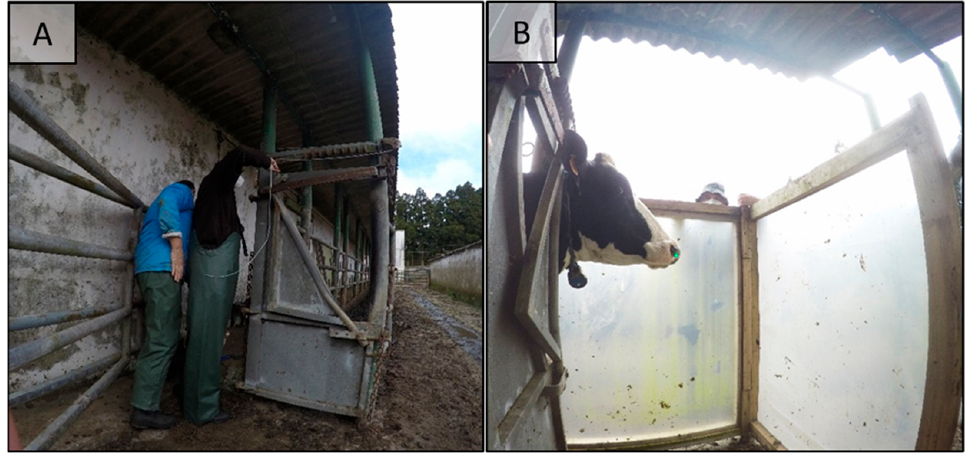
Figure 1. The actual image of the place where LMD was operated, captured with a wide-angle lens. ( A ) Handling race with a cattle head holder at the end for cattle contention; ( B ) positioning of wind protection panels during an LMD measurement (laser is visible as a green dot in the right nostril). A series of algorithms were created to collate individual files containing the measured CH 4 values (signal), identify peaks, and compute the CH 4 traits of each cow at a single time point (profiles), using Python 3.10. Figure 2 depicts one CH 4 profile and the sequence of calculations to obtain the CH 4 traits. First, potential artifacts were removed by applying a cap value of 1000 to 481 out of ≈ 130,000 CH 4 measured values (unphysiological high). Second, the arithmetic mean ( 𝜇 ) and standard deviation ( 𝜎 ) of the signal within a profile (Figure 2A) were calculated. Third, a threshold ( 𝑇 ) for each profile was defined as 𝑇 (cid:3404) 𝜇 (cid:3397) 𝜎 . The signal was then divided into a respiratory (Figure 2B) and eructation (Figure 2C) component, based on the 𝑇 . The respiratory and eructation signals were then processed to allow the identification of respiratory and eructation peaks, based on their prominence (simply, how much the peak stands out due to its intrinsic height, and its location relative to another peak). The division into components enabled the identification of eructation events and the estimation of respiratory rate. The respiratory rate was estimated from the respiratory peaks. For the identification of eructation events, a low-pass filter (2nd order Butterworth filter) was applied to soothe the signal and remove the short-term fluctuations, leaving the longer term trend (Figure 2D). The methane traits of each profile included the MEAN_CH 4 (arithmetic mean of all peak values), E_CH 4 (arithmetic mean of eructation peak values), and R_CH 4 (arithmetic mean of respiratory peak values). Complementarily, the percent shares of eructation and respiratory emissions were estimated from the sum of CH 4 eructation peak values (SUM_E_CH 4 ) and the sum of respiratory peak values (SUM_R_CH 4 ) divided, respectively, by the sum of all CH 4 peak values (SUM_CH 4 ).